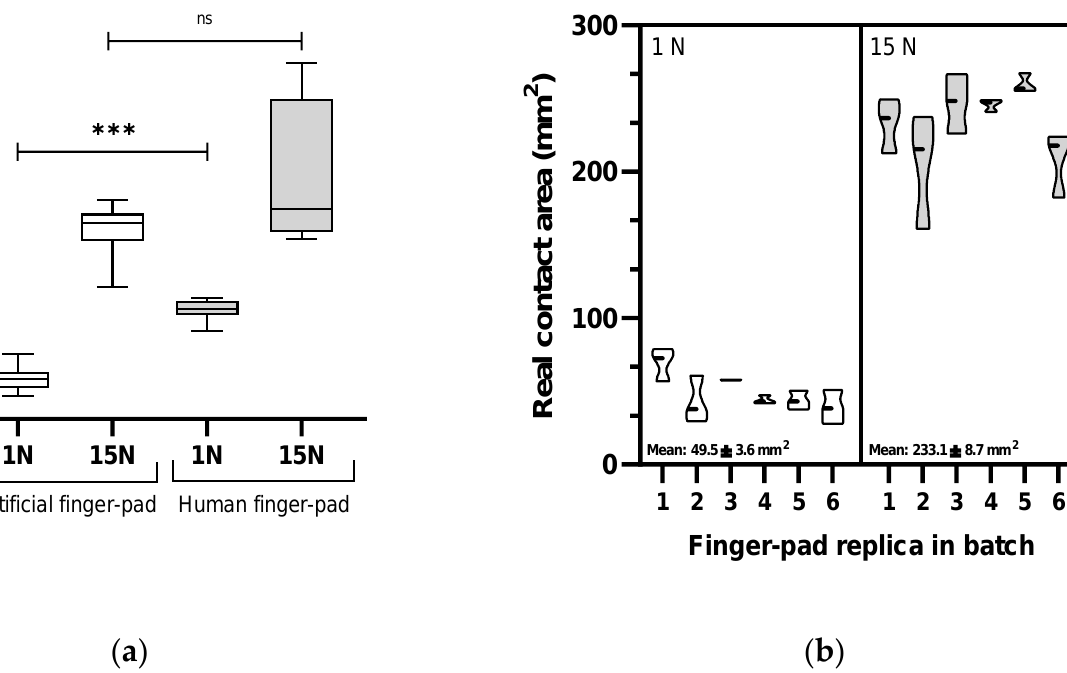
Figure 4. Characterization of artificial finger-pads. ( a ) Comparison of effective contact areas of artificial finger-pad and human finger counterpart at two forces, and ( b ) reproducibility of effective contact area across a batch of replica finger-pads. *** = significance ( p < 0.05), ns = not significant ( p > 0.05).